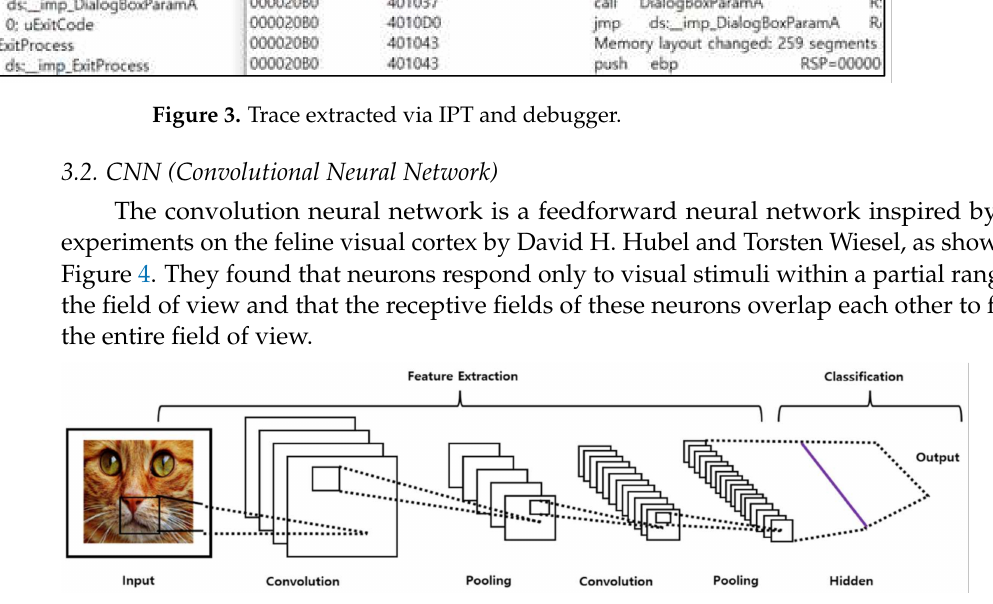
Figure 4. Convolution neural